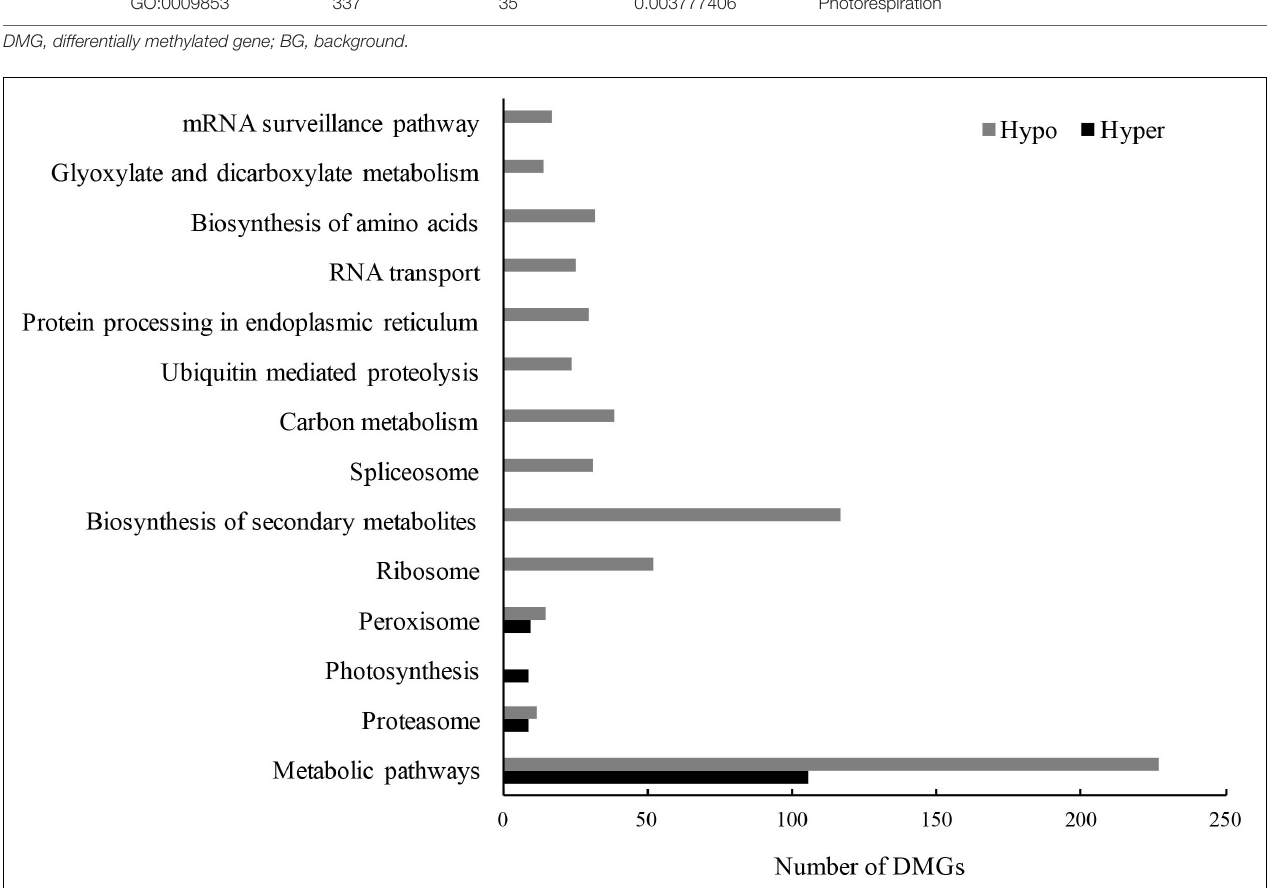
FIGURE 7 | Significant KEGG enrichment pathways of hyper- and hypo-DMGs between the WT and the cco mutant ( p -value after FDR correction <